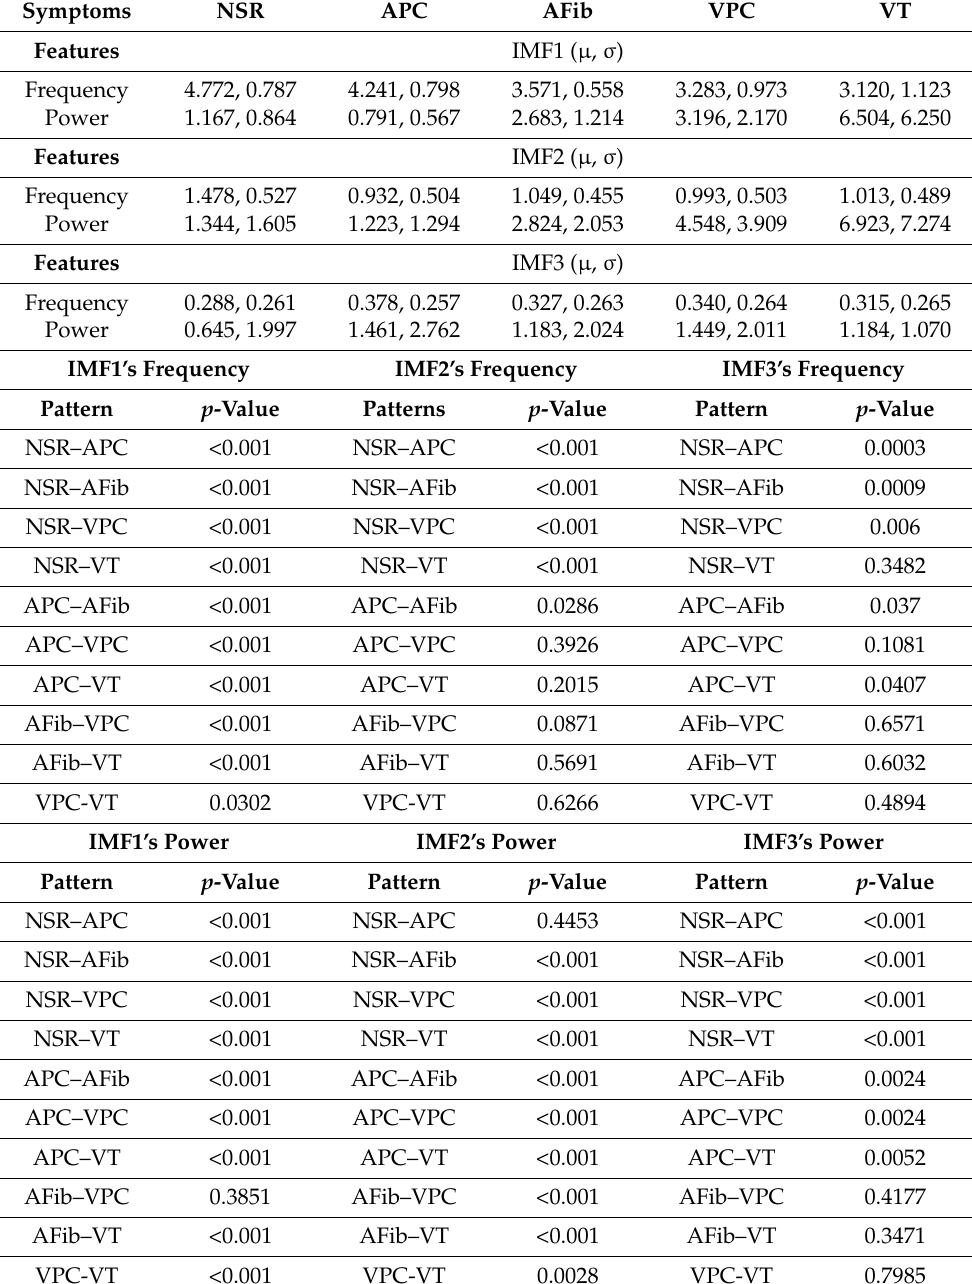
Table 1. HHT-based feature distribution of the observed samples for the